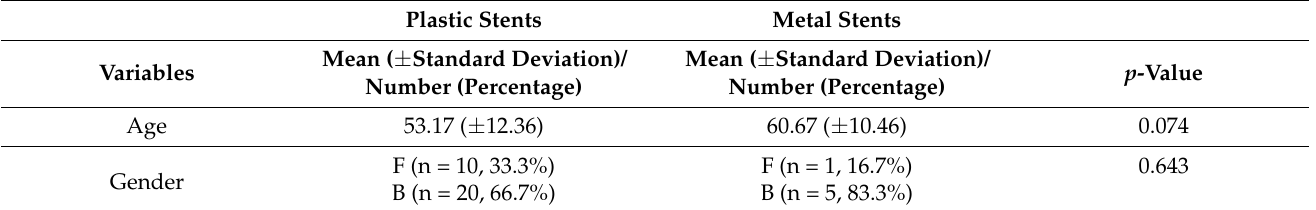
Table 1. Patients’